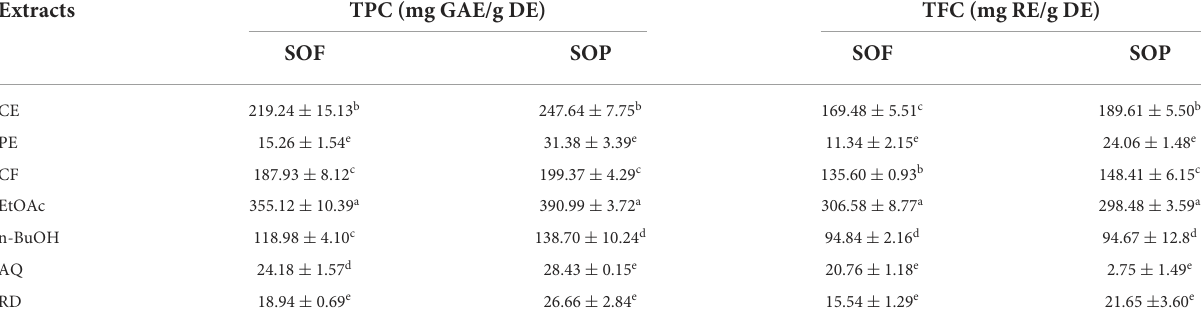
TABLE 2 Total phenolic content and total flavonoid content of